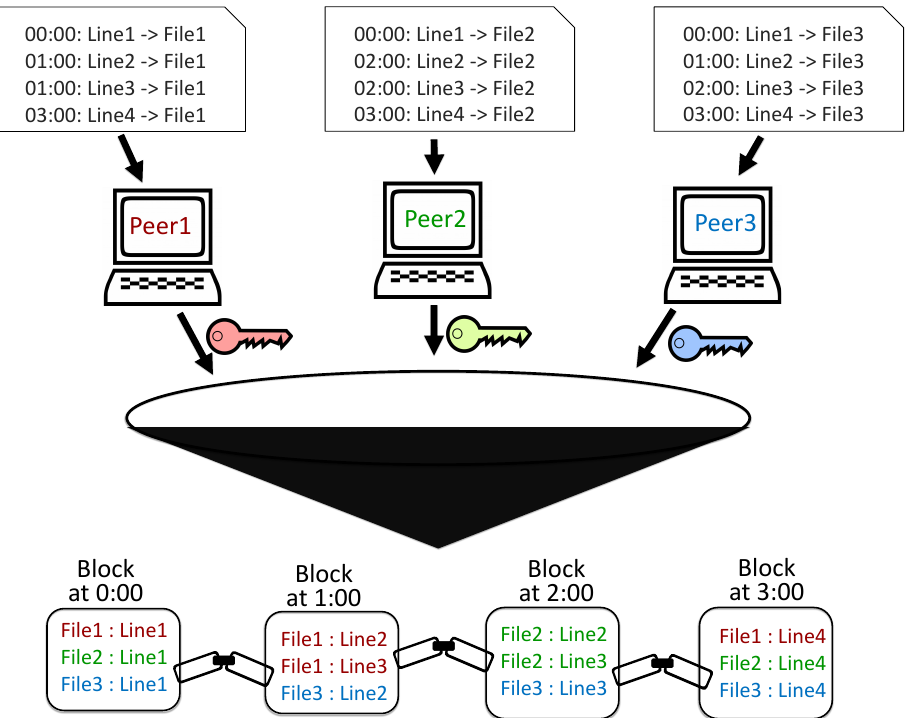
Figure 2. The process of writing logs to the blockchain: unencrypted files are encrypted by each peer with its own key. The encrypted lines of the file are then written to the